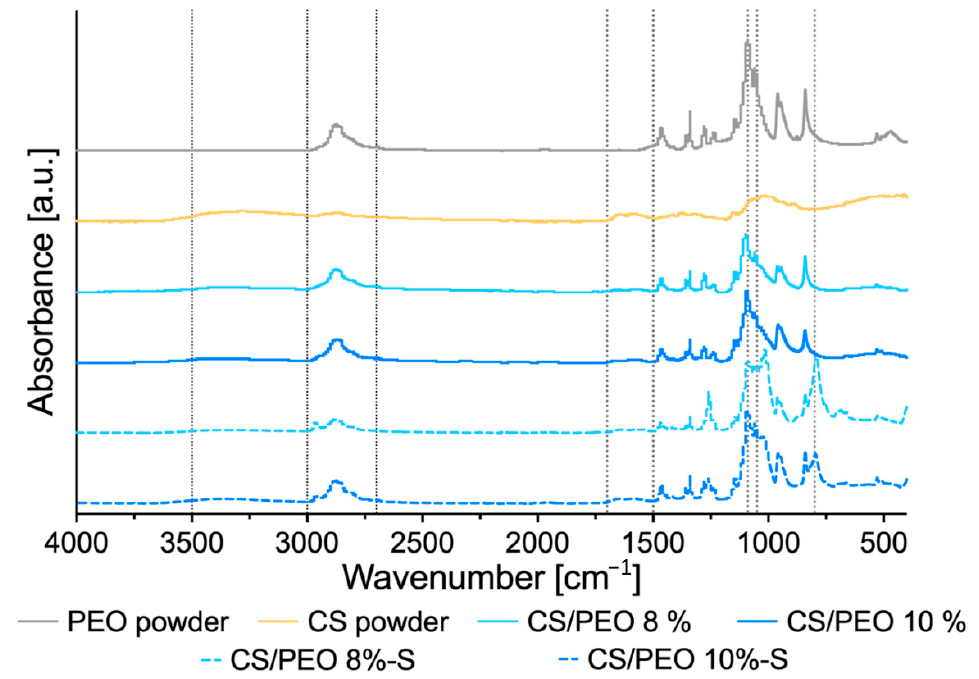
Figure 2. ATR-FTIR of pure poly(ethylene oxide) (PEO), chitosan (CS), uncoated nanofibers prepared of 8% ( w/w ), or 10% ( w/w ) CS/PEO solution and corresponding poly(dimethylsiloxane) modified nanofibers CS/PEO-S.